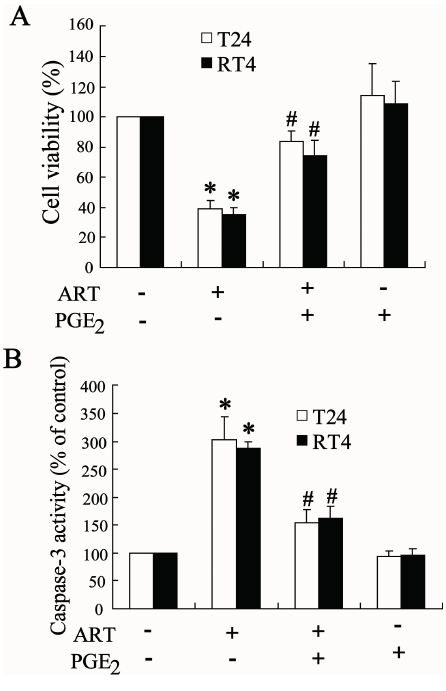
Figure 7. Exogenous PGE2 can reverse the effect of ART on inhibition of bladder cancer cells growth. After pretreated with exogenous PGE2 (10 μ M) for 2 h, T24 and RT4 cells were added with ART (100 μ M) for an additional 48 h, and then cell viability and caspase-3 activity were determined ( A , B ). * p < 0.05, compared to vehicle controls group. # p < 0.05, compared to only ART (100 μ M) treated